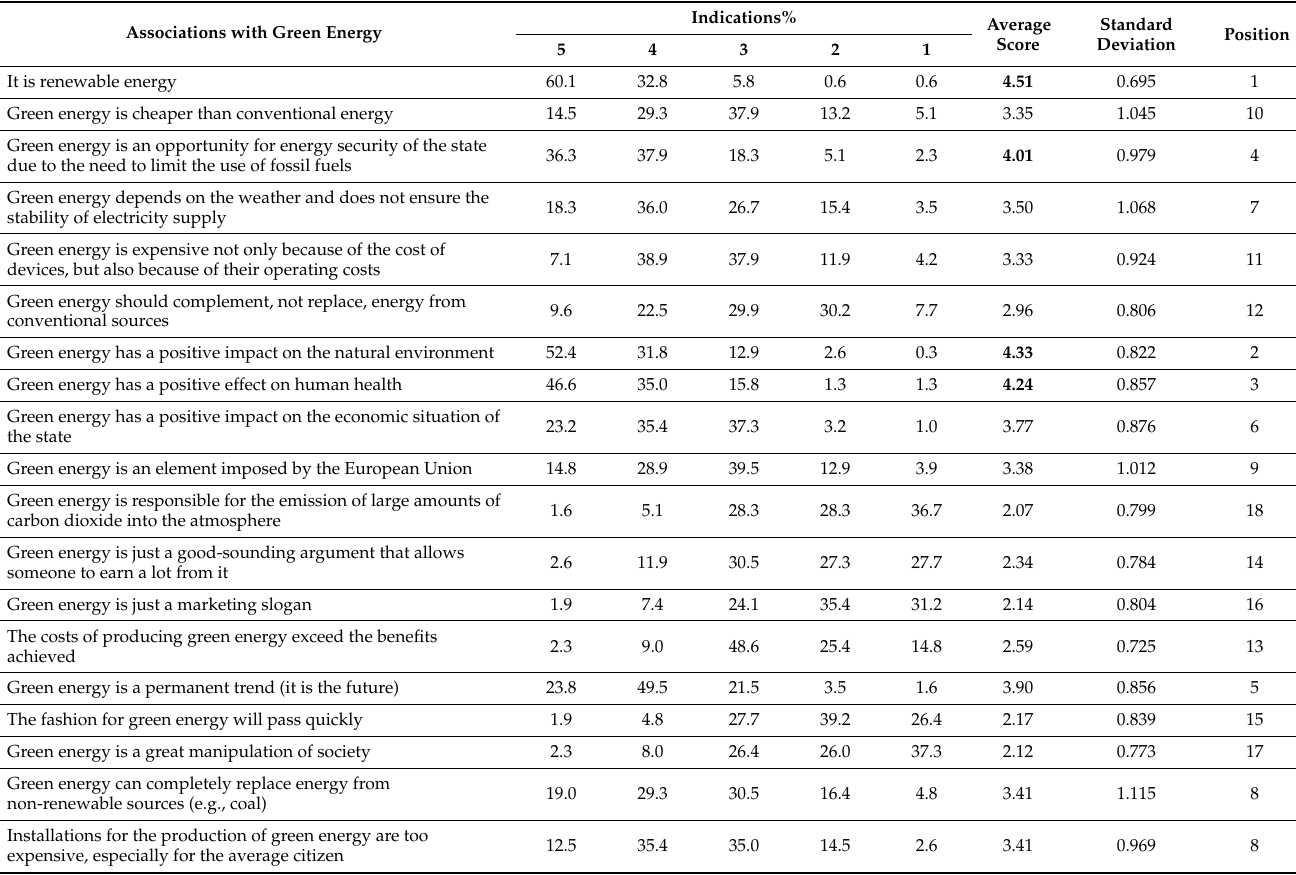
Table 1. Respondents’ associations with green